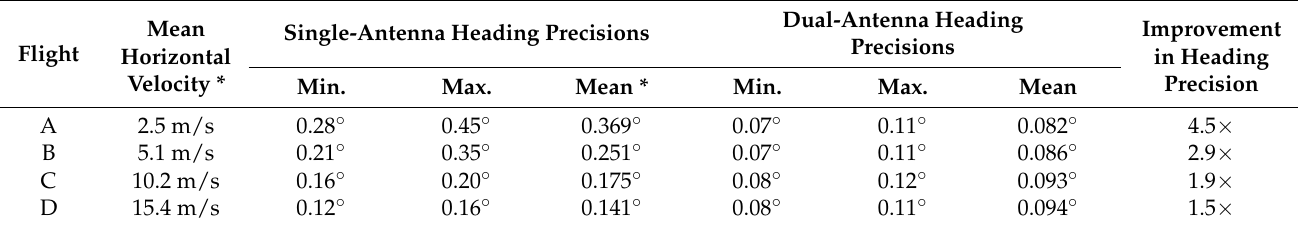
Figure 9. Single and dual-antenna GNSS/INS heading precisions for all flights of the experiment. An inspection of Figure 9 indicates a negative correlation between horizontal velocity Table 4. Quantitative measures for single and dual-antenna GNSS/INS heading and heading precisions for single-antenna GNSS/INS sensors. The single-antenna heading